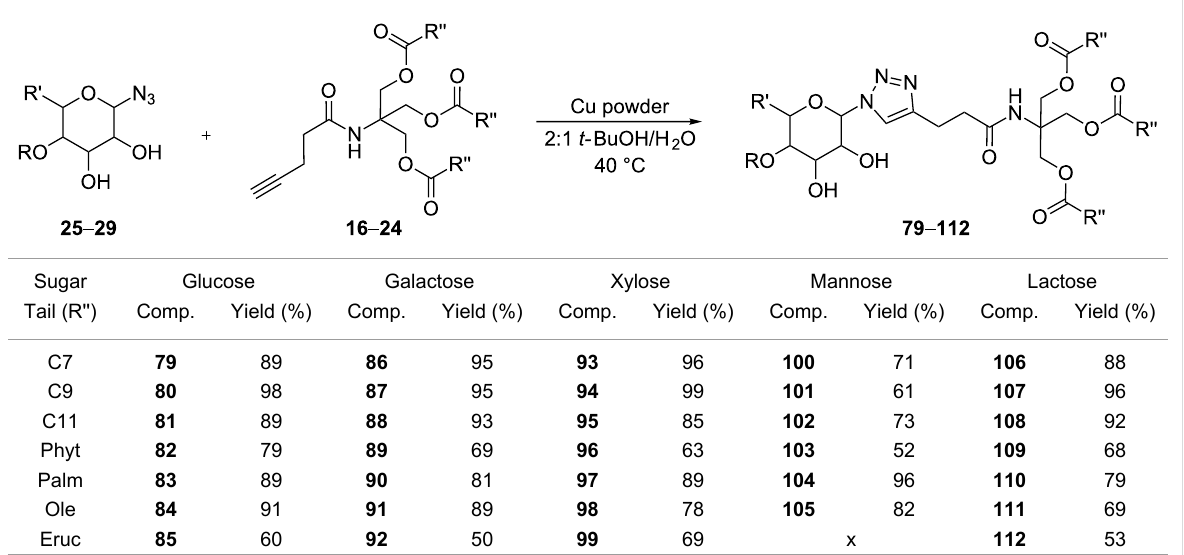
Table 4: Copper content analysis of amphiphiles. a